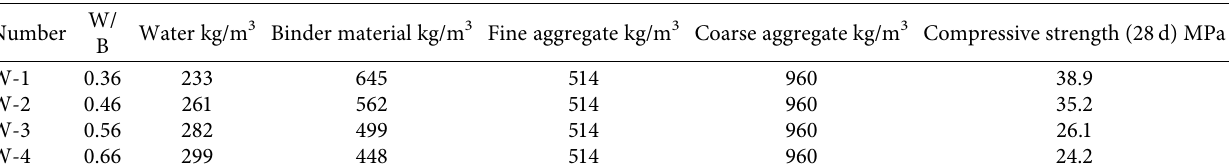
Table 4: Mix proportion of concrete.